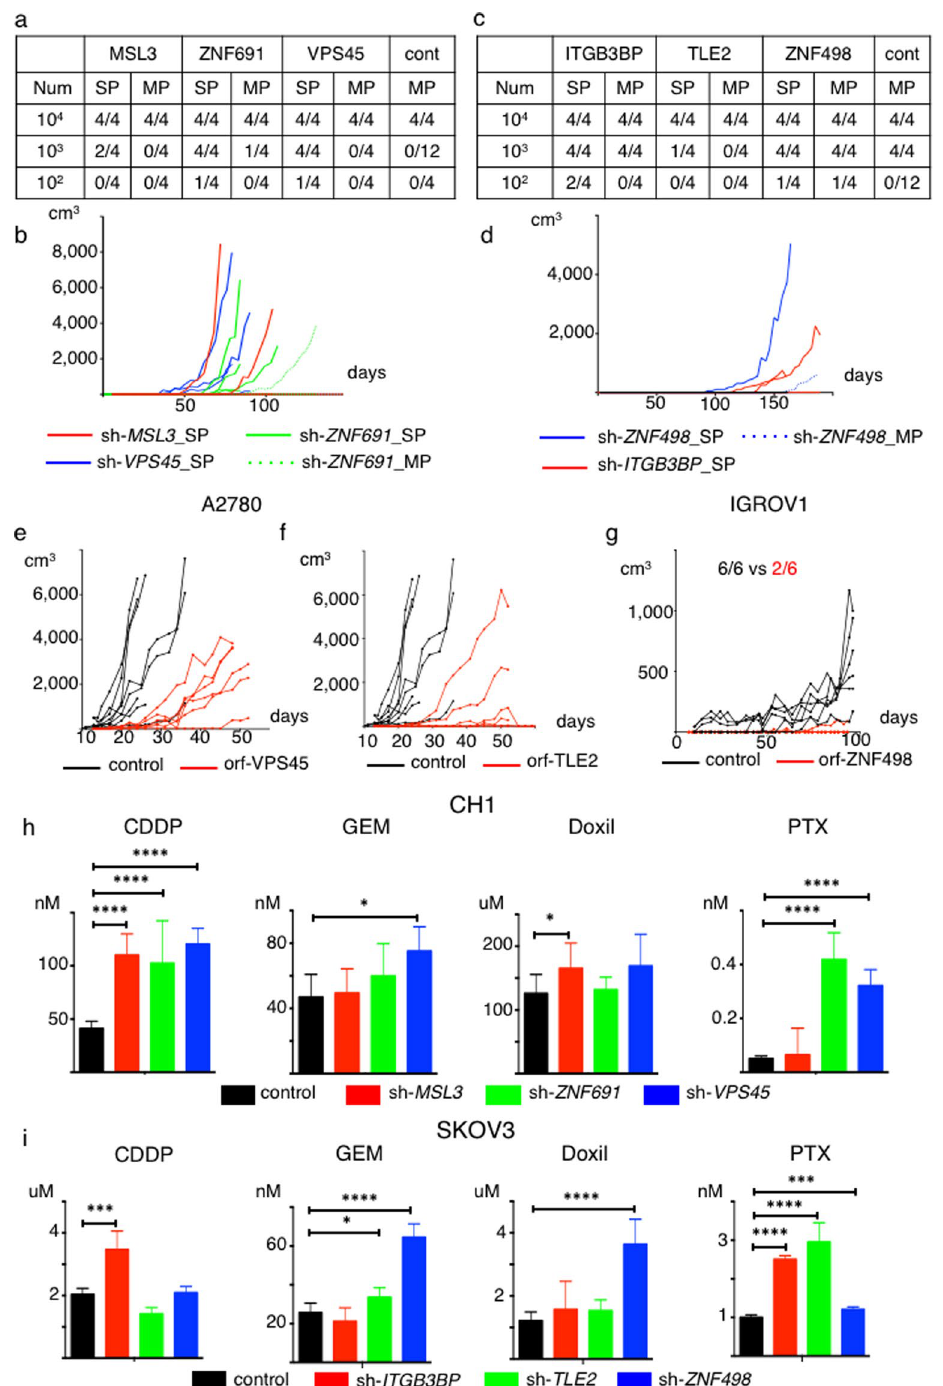
Figure 4. Target genes regulate tumor initiating ability and in vivo tumor proliferation, and suppression of six genes enhances resistance to chemotherapeutic agents. ( a , b ) Newly generated SP cells exhibit greater tumor initiating capability than do MP cells and control cells. Data from CH1-control, SP and MP cells derived from CH1 sh-target gene cells are shown. Num; Number, cont; control-MP. ( a ) Limiting dilution assay results. ( b ) Tumor growth curves generated from injection of 1 × 10 3 indicated cells. ( c , d ) Newly generated SP cells exhibit greater tumor initiating capability than do MP cells and control cells. Data showing tumor initiating ability for SKOV3-control, SP and MP derived from SKOV3 sh-target gene cells are shown. Num; Number, cont; control-MP. ( c ) Limiting dilution assays. ( d ) Tumor growth curves generated from injection of 1 × 10 2 indicated cells. ( e – g ) Overexpression of VPS45 , TLE2 , ZNF498 decreases in vivo tumor proliferation. ( e ) Tumor growth curves generated from injection of 1 × 10 5 A2780 control or ORF-VPS45 cells. ( f ) Tumor growth curves generated from injection of 1 × 10 5 A2780 control or ORF-TLE2 cells. ( g ) Tumor growth curves generated from injection of 1 × 10 6 IGROV1 control or ORF-ZNF498 cells. ( h , i ) Suppression of six genes